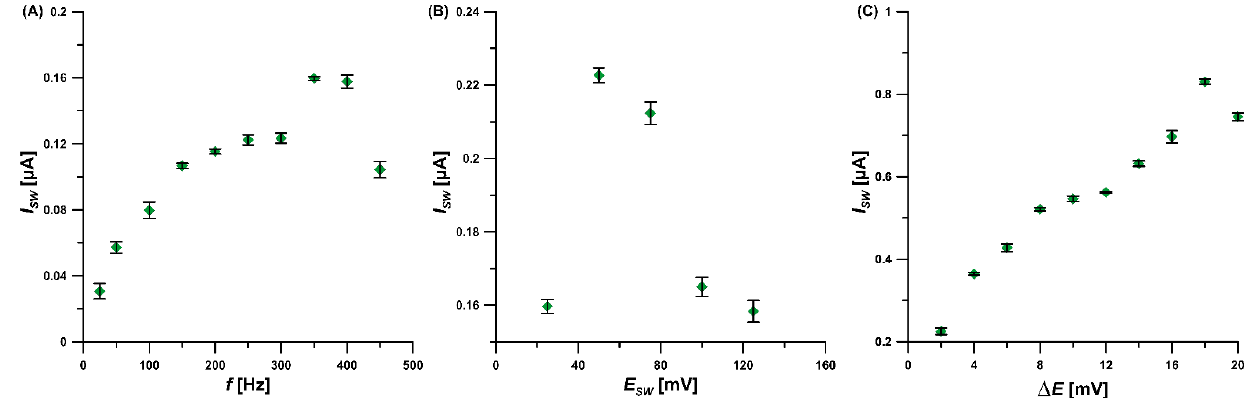
Figure 7. The relationship between I SW and f ( A ) as well as E SW ( B ) and ∆ E ( C ) for the 1 µ M ROX peak current. The standard deviation was calculated for n =